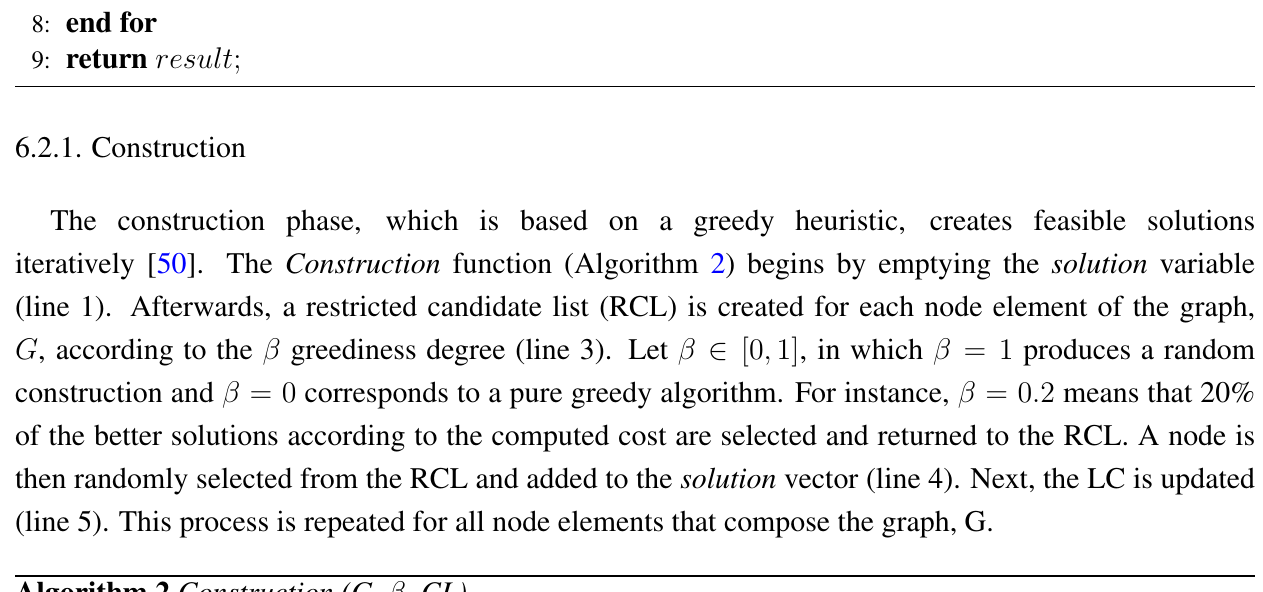
Algorithm 2 Construction (G, β ,